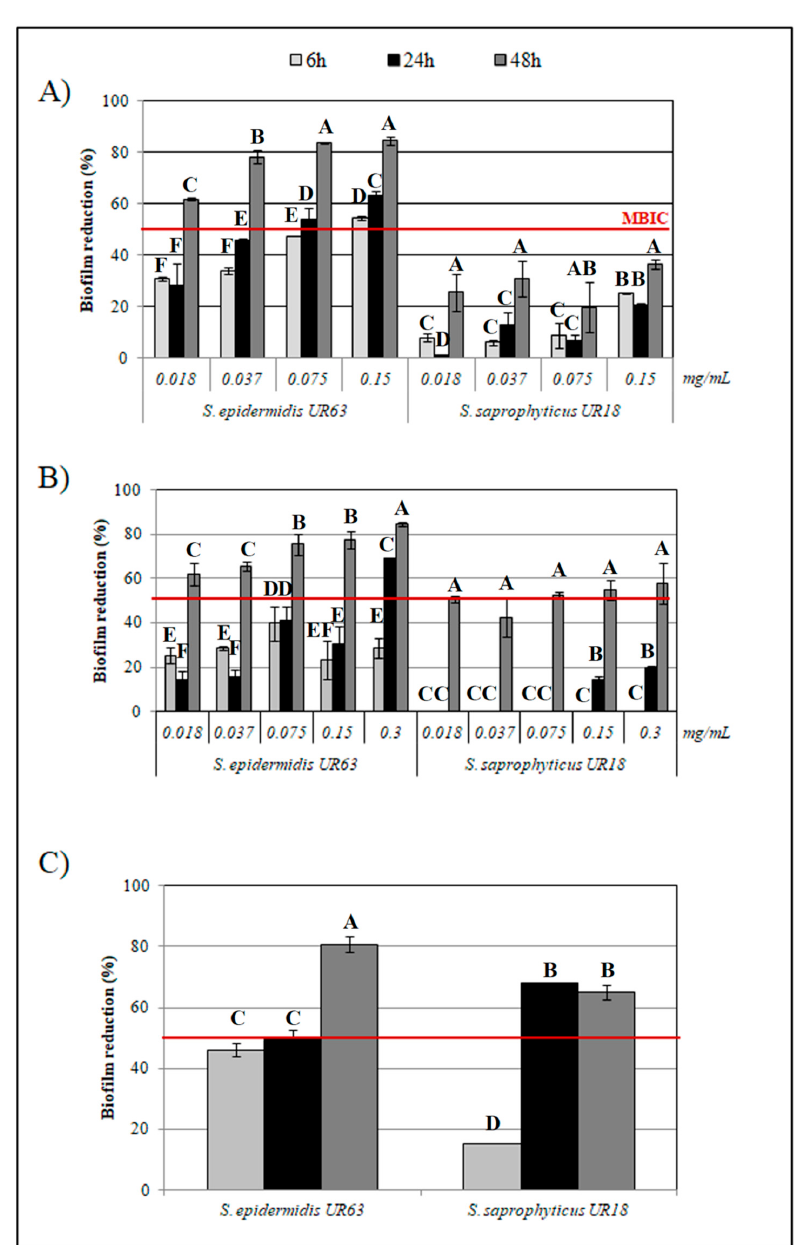
Figure 3. Biofilm reduction percentage in S. epidermidis UR63 and S. saprophyticus UR18 in vitro cultures amended with ( A ) 0.018, 0.037, 0.075, 0.15 mg/mL of Lactoferricin B (LFcinB); ( B ) 0.018, 0.037, 0.075, 0.15, and 0.3 mg/mL of Lactoferrampin (LFampin); ( C ) LFcinB and LFampin mixture (0.037 mg/mL) at 6, 24, 48 h of incubation. Line represents the calculated minimal biofilm inhibitory concentration (mg/mL; MIBC). Bars are the mean ± standard deviation ( n = 3). Different letters represent statistically different values ( p < 0.05) based on Kruskal-Wallis analysis followed by Dunn’s post hoc tests.